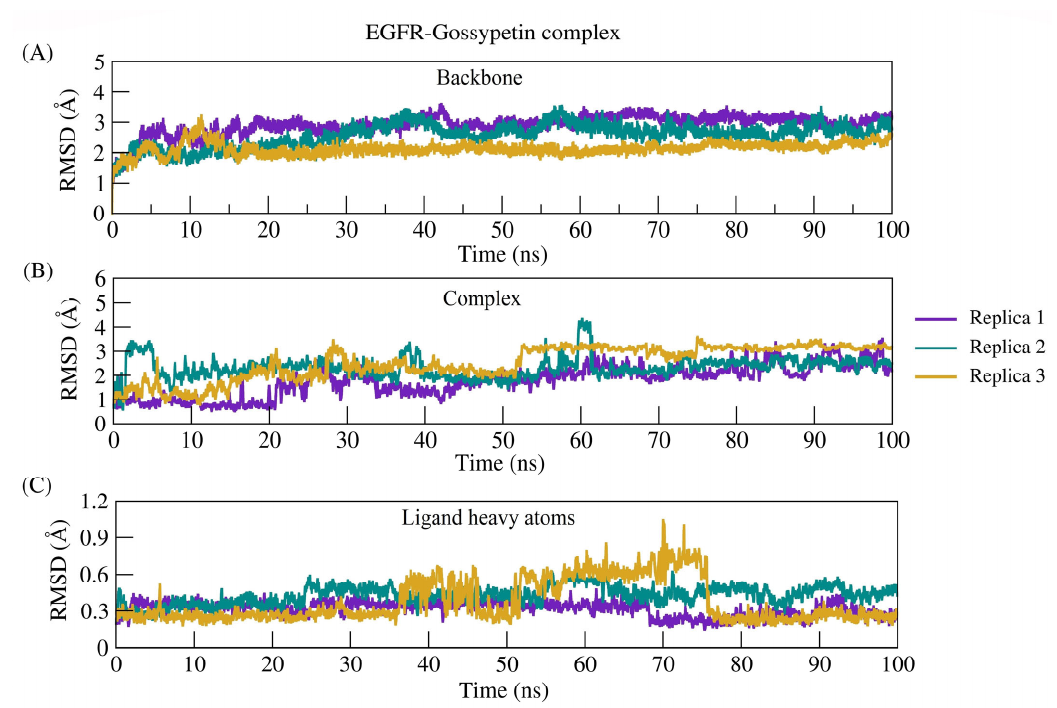
Figure 9. Gossypetin with WT–EGFR 100ns MD production run. ( A ) RMSD plot depicting the “protein backbone”. ( B ) Plot depicting the docked complex stability “ligand–protein complex RMSD”. ( C ) Plot depicting the stability of “ligand w.r.t. ligand”.